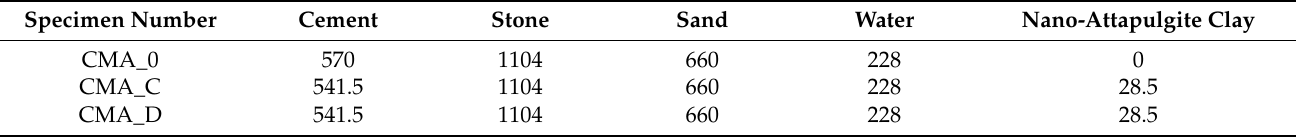
Table 2. Mixing proportion of concrete kg · m − 3 .